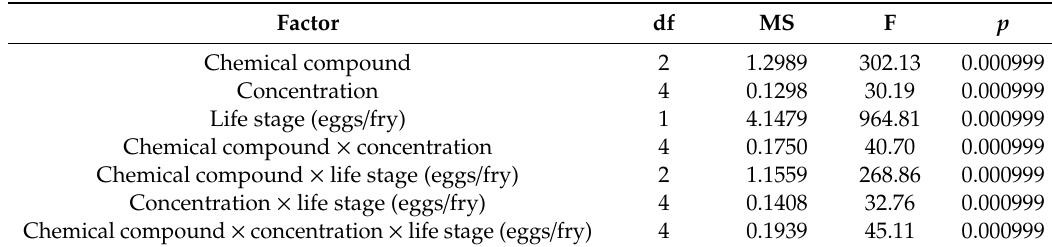
Table 8. PERMANOVA analysis of factors (chemical compound, concentration, life stage, and their combinations) a ff ecting the Cu